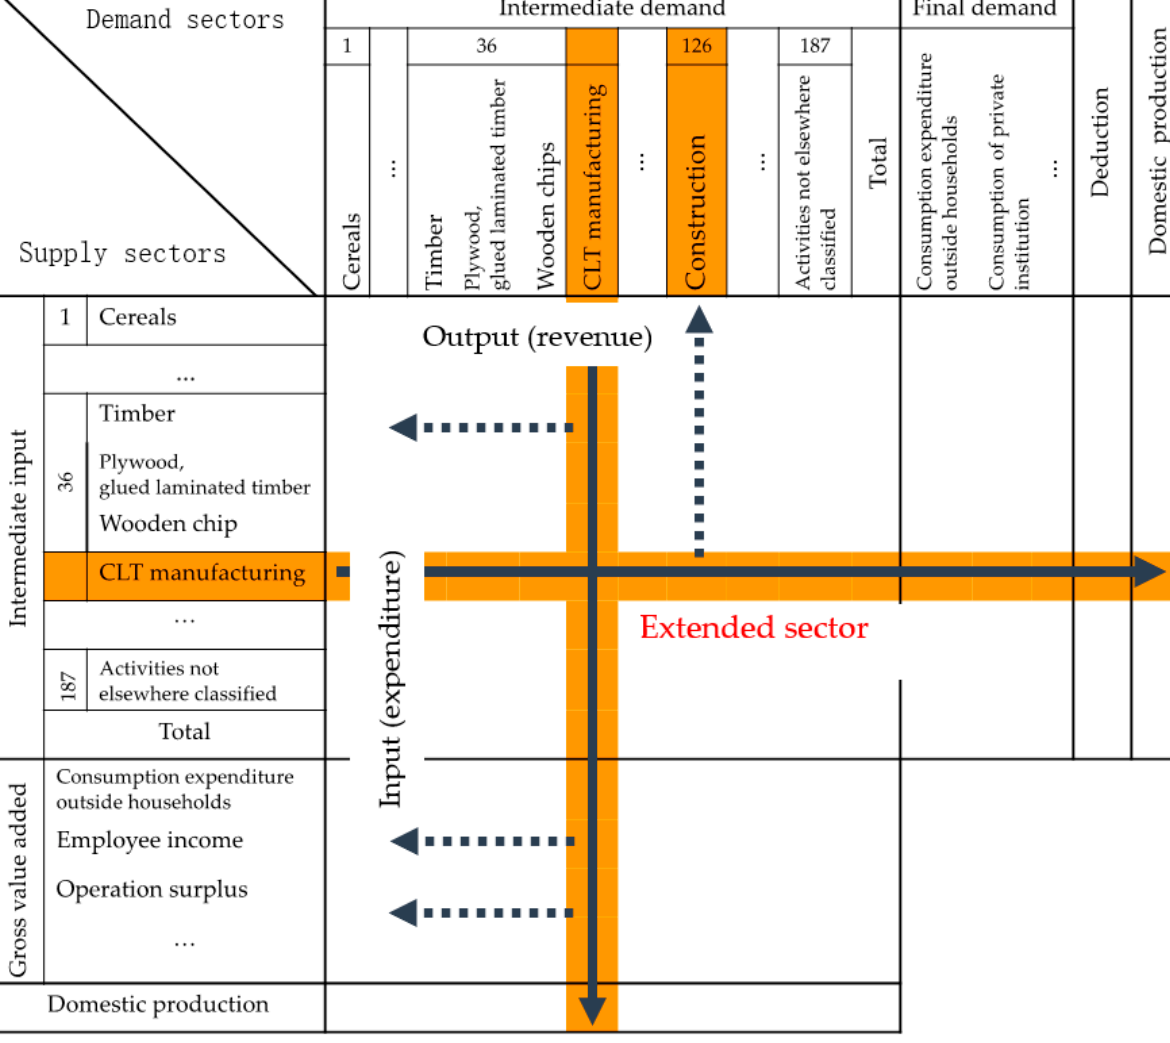
Figure 3. Schematic diagram of the extended input–output table.